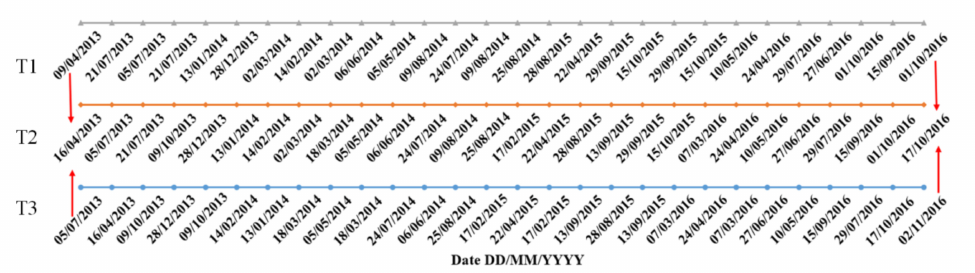
Figure 2. The scheme for estimation of Landsat 8-like LST by STARFM, ESTARFM, and